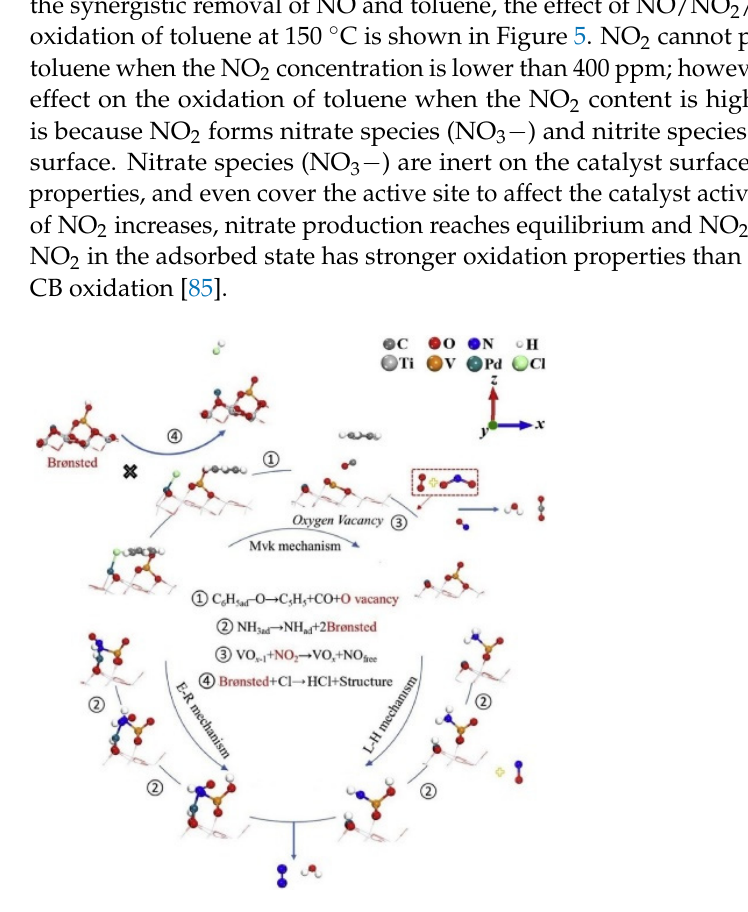
Figure 4. Synergistic removal mechanism of NO x /CB on PdV/TiO 2 [83]. Copyright 2021, Elsevier B.V.